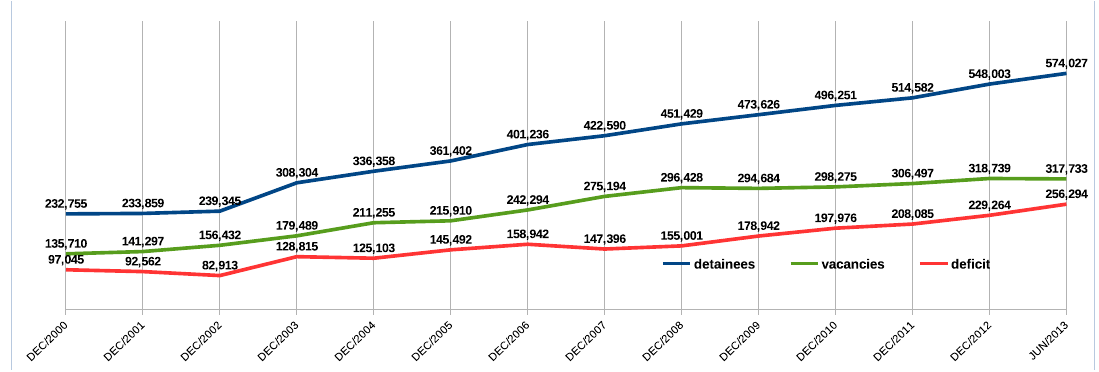
Figure 1. Evolution of the Brazilian incarcerated population; source: authors adapted from